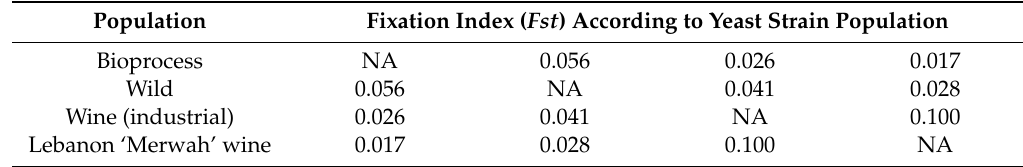
Table 4. Pairwise fixation indices calculated using the distance